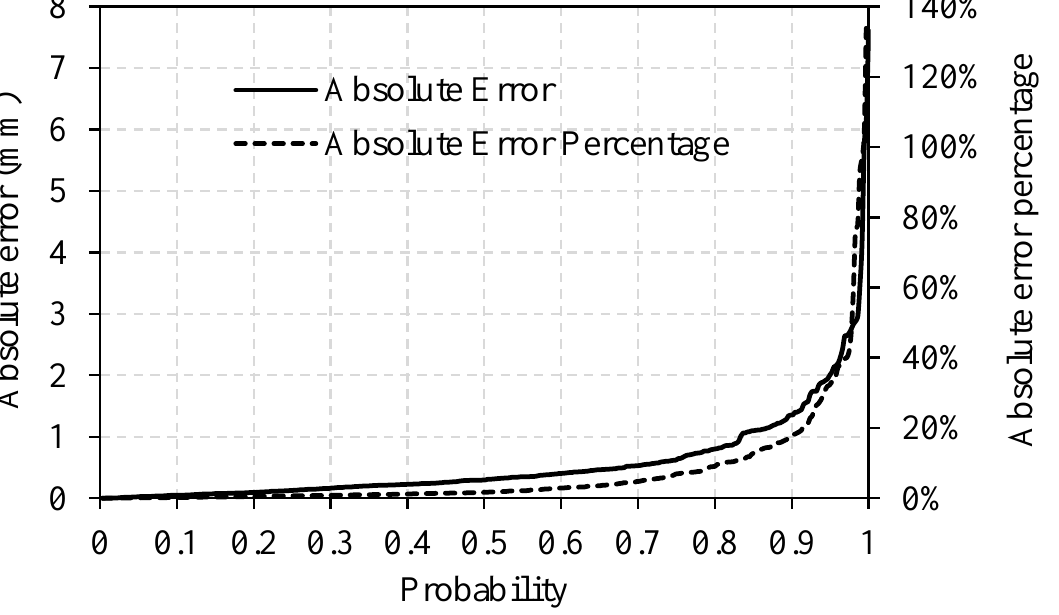
Figure 8. Cumulative probability distribution of prediction errors. Table 2. Average prediction errors of the optimum BPNN.